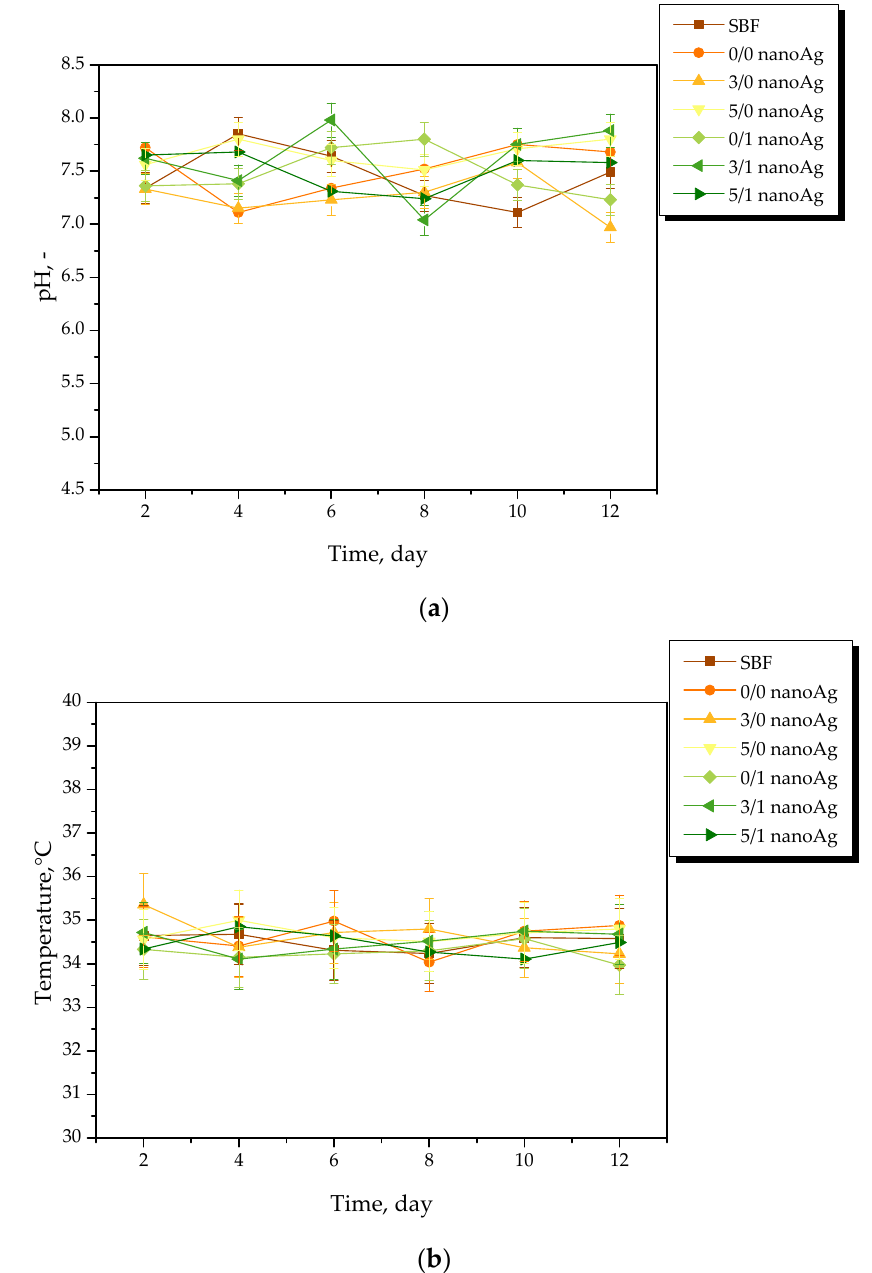
Figure 5. pH ( a ) and temperature ( b ) measurements of SBF during hydrogels’ incubation (n = 3, n—number of repetitions).